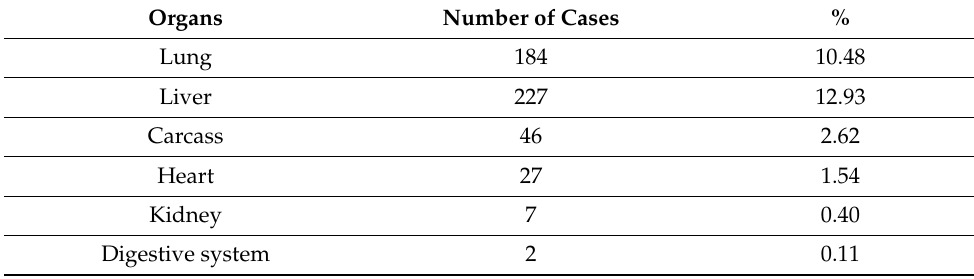
Table 1. Overall data concerning the number of positive